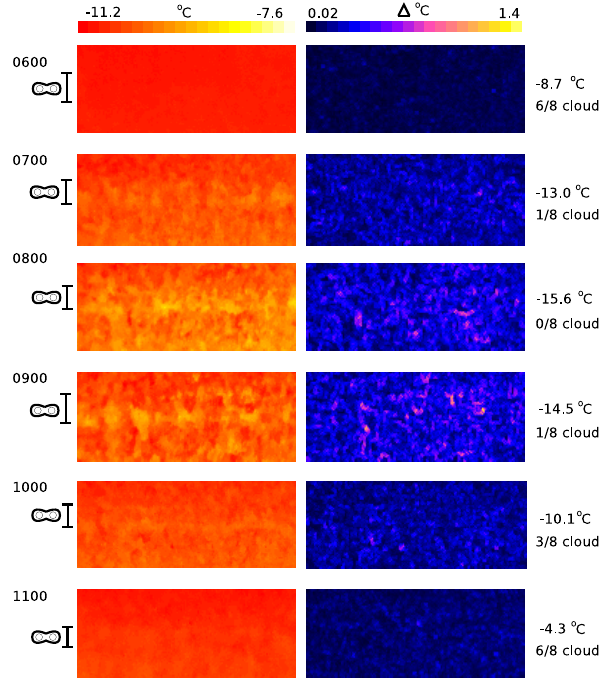
Fig. 6. Temperatures (left images) and point gradients (right im- ages) over five hours on the morning of 3 March 2011. Air temper- atures and cloud cover are listed on the far right. The hour of mea- surement and crust location (vertical placement and 1cm height) are noted on the far